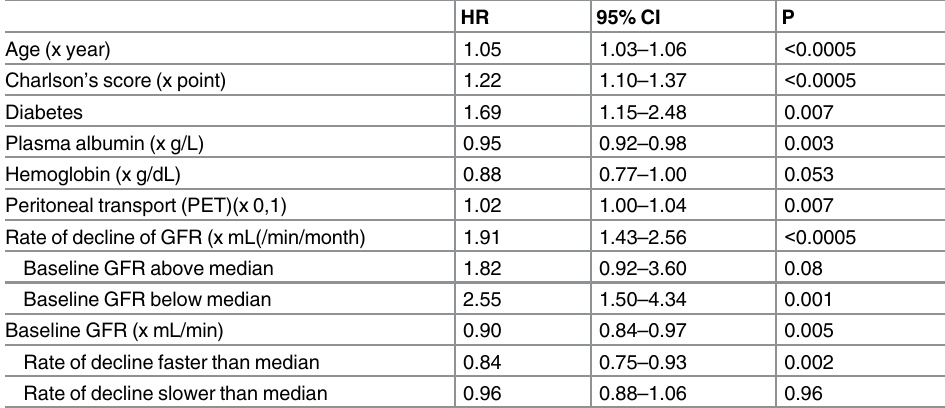
Table 3. Predictors of mortality of patients starting PD. Multivariate analysis.